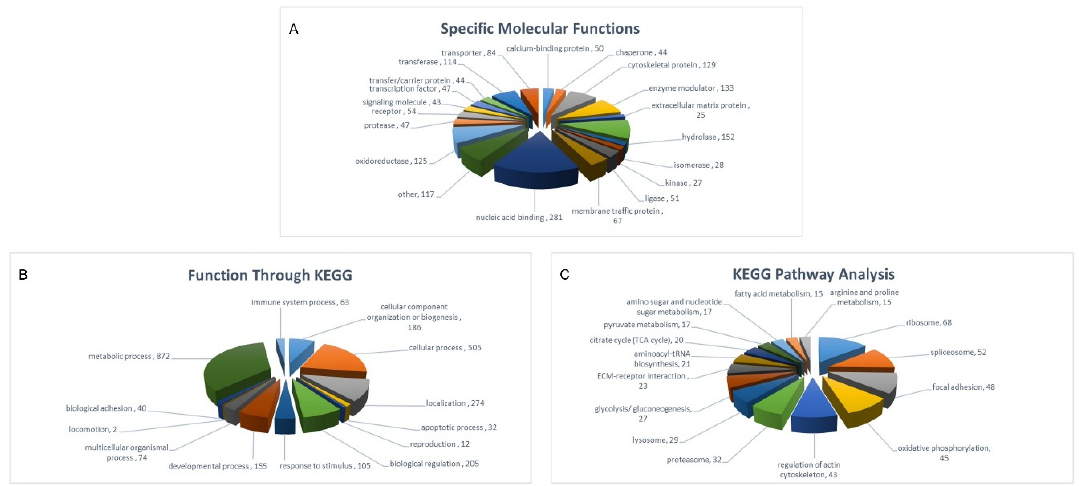
Figure 2. Bioinformatics dissection of the SHED-PDLSC “consensus” proteome generated via nano-LC-MS/MS employment. ( A ) Classification of the SHED-PDLSC “consensus”-proteome contents into several categories of “Specific Molecular Functions”. The Gene Ontology (GO) sub-routine of DAVID program was the bioinformatics tool engaged. p < 0.05. ( B ) Categorization of the SHED-PDLSC “consensus”-proteome components into groups carrying broad (general) cellular functions, through KEGG-pathway utilization (“Function Through KEGG”). ( C ) Assembly of the SHED-PDLSC “consensus”-proteome contents into clusters of specific cellular processes, by KEGG-pathway